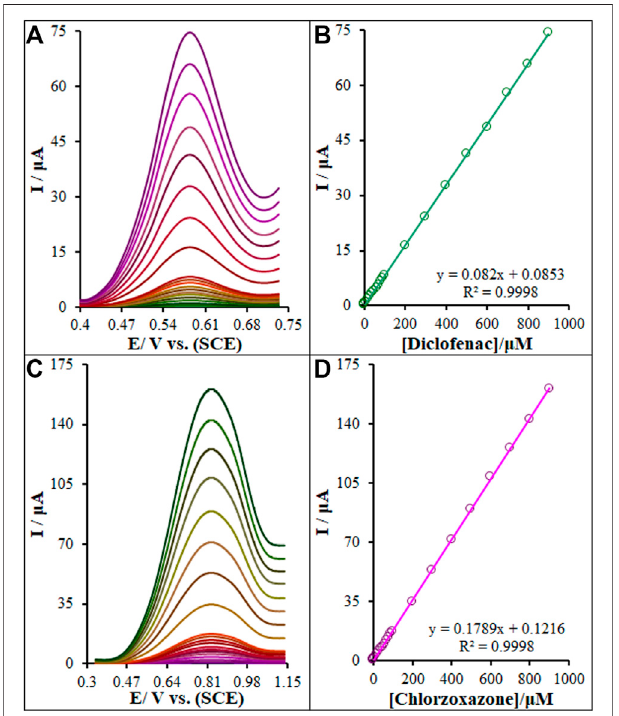
FIGURE 11 | (A) and (C) DPVs of the La 2 O 3 @SF-L Cu 2 S/GCE in 0.1 M (pH 7.0) containing different concentrations of diclofenac and chlorzoxazone, respectively (from inner to outer curve): 0.01, 0.1, 1.0, 10.0, 20.0, 30.0, 40.0, 50.0, 60.0, 70.0, 80.0, 90.0, 100.0, 200.0, 300.0, 400.0, 500.0, 600.0, 700.0, 800.0, and 900.0 µM. (B) and (D) Plots of the electrocatalytic peak currents as a function of diclofenac and chlorzoxazone concentrations in the range of 0.01 – 900.0 µM, respectively.